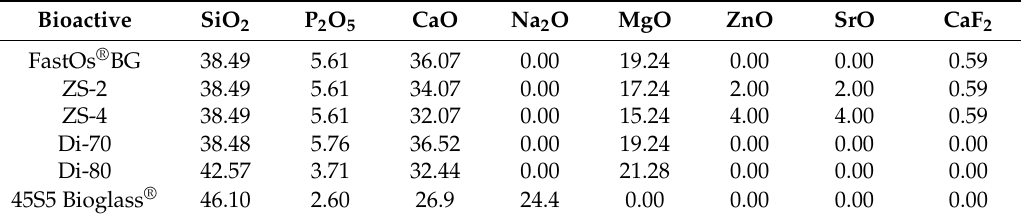
Table 14. Bioactive glasses compositions (mol